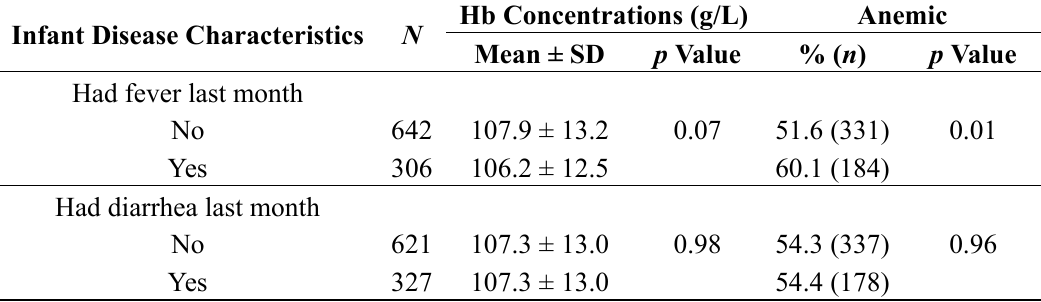
Table 7. Hemoglobin concentrations and anemia prevalence of sample infants in rural Shaanxi Province by disease characteristics.